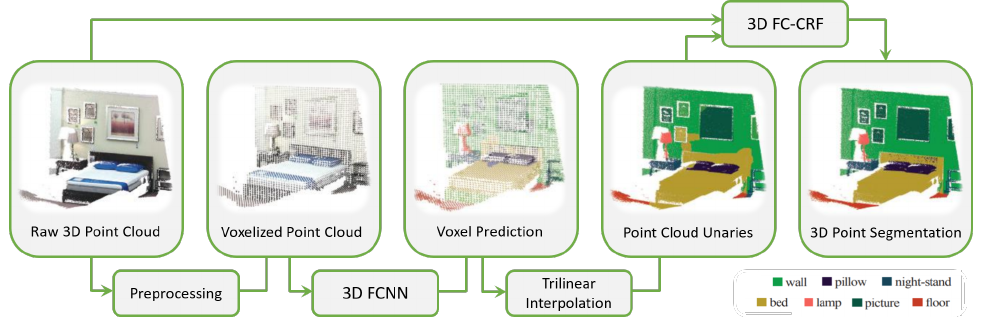
Figure 6. SegCloud [54]